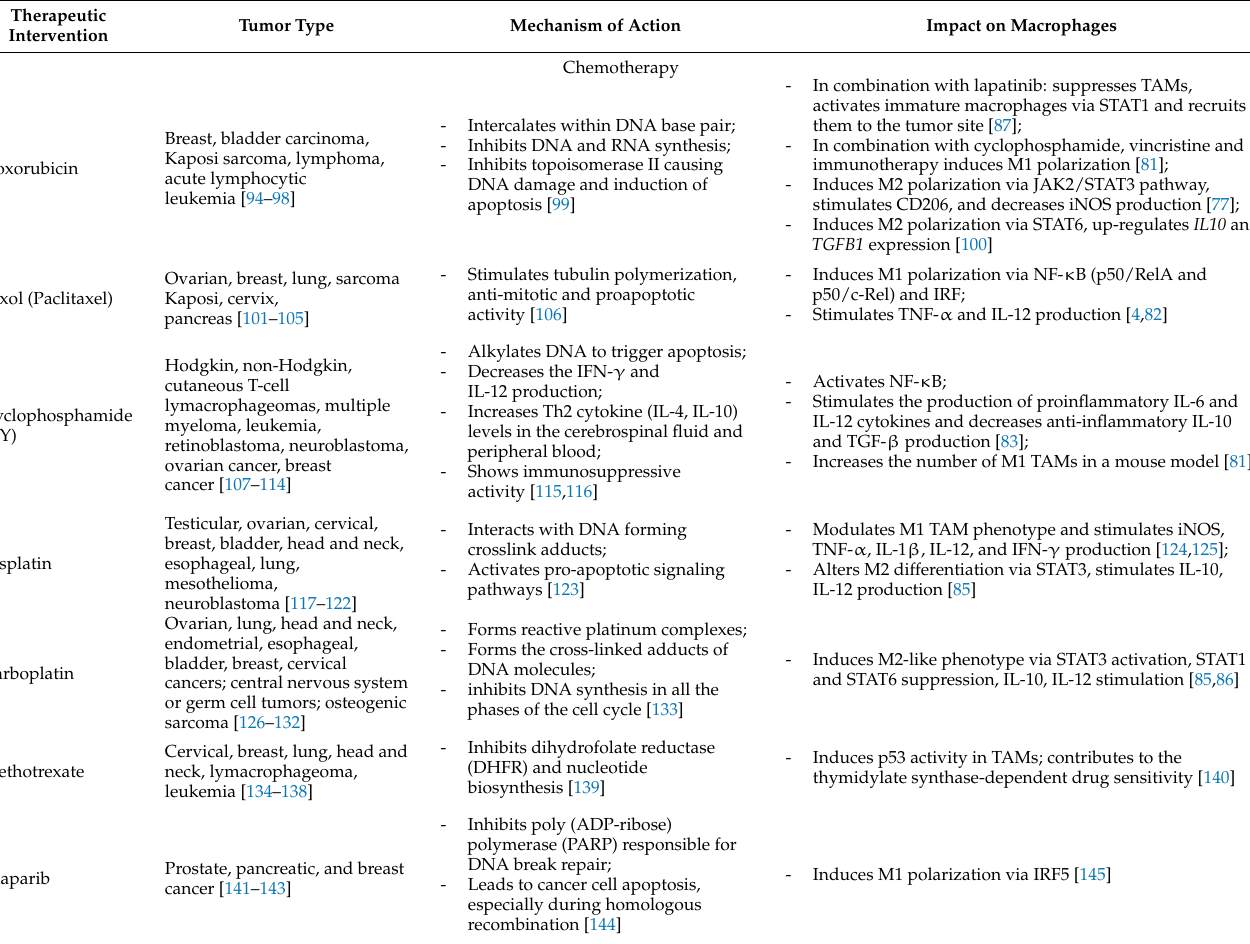
Table 3. Effects of chemotherapy and radiotherapy on macrophage